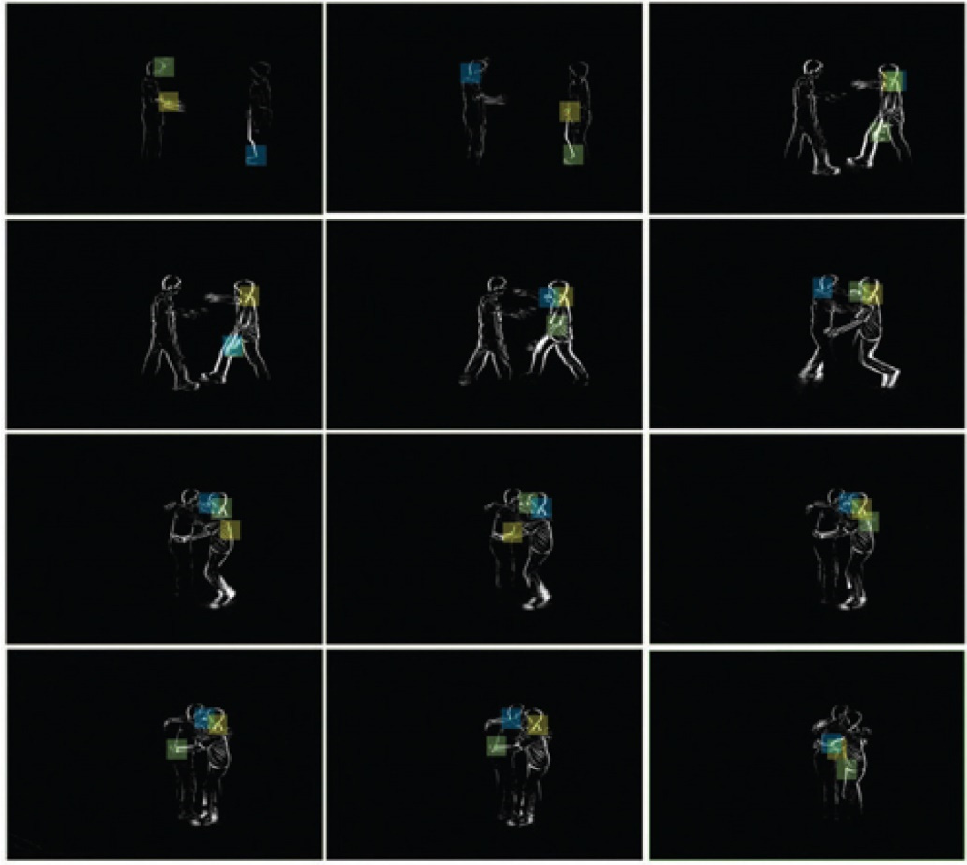
Figure 4. Illustration of the location of the extracted spatial-temporal interest points for action ‘hug’. The highlighted points indicated the interest points of each frame.